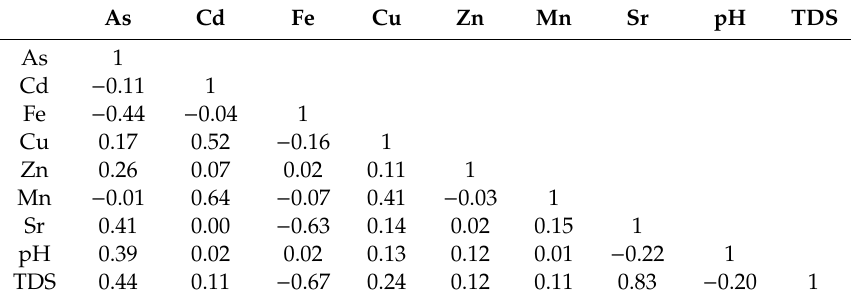
Table 6. Correlation matrix among heavy metal, pH, and salinity in the Lhasa River. As Cd Fe Cu Zn